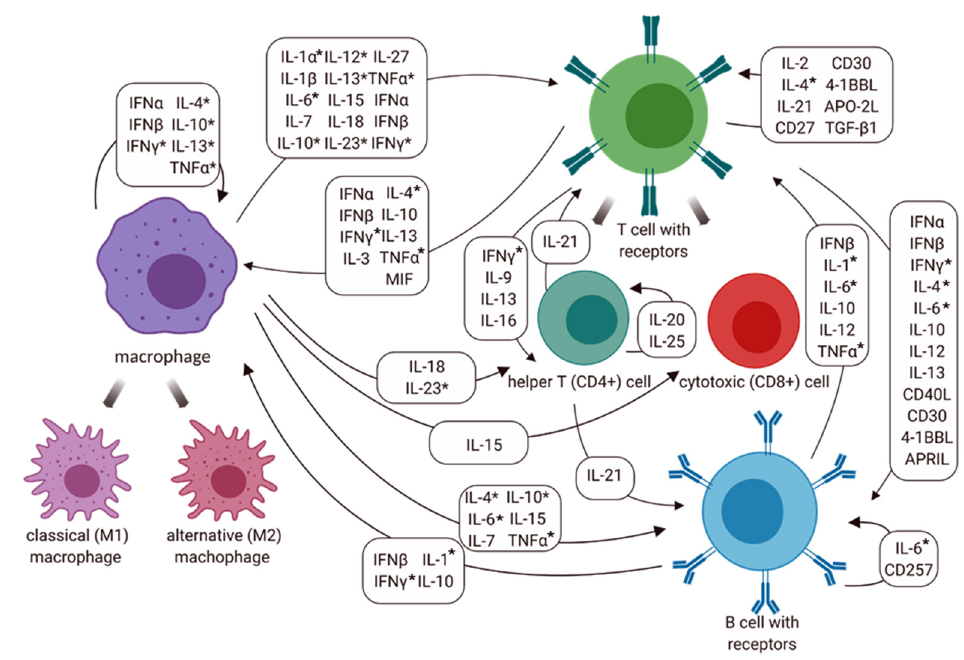
Figure 7. Cytokine network involved macrophage, T cell (CD4+ and CD8+) and B cell activation in